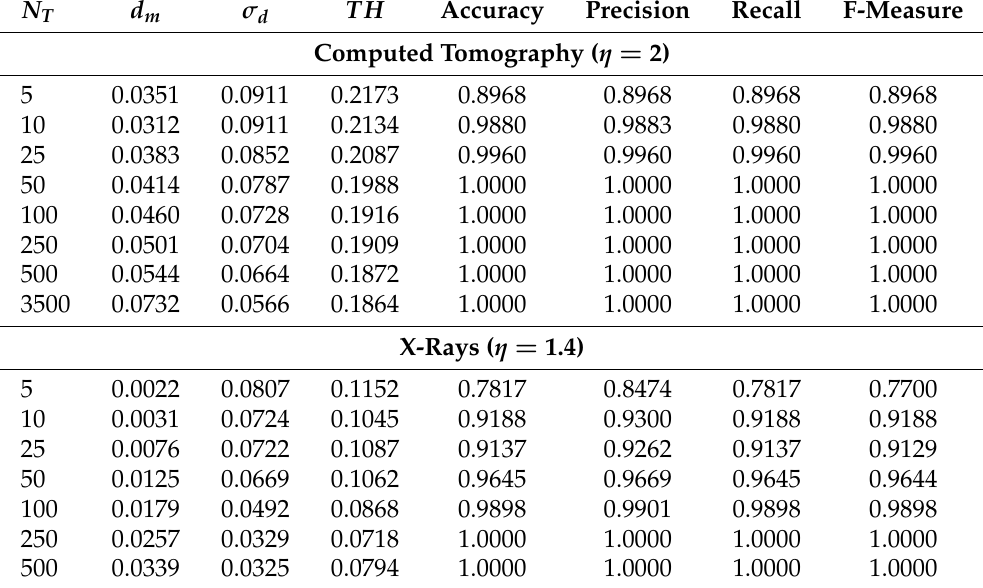
Table 7. Results obtained by the proposed approach at different number N T of target images. The metrics have been evaluated by using the cosine distance and N bin = 50 histogram bins. N T d m σ d TH Accuracy Precision Recall F-Measure Computed Tomography ( η =